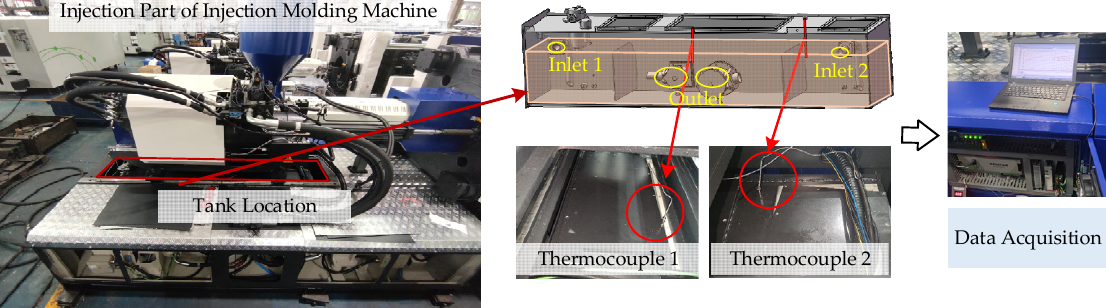
Figure 1. Heat balance experiment of injection molding machine tank. The distance between Thermocouples 1 and 2 was 0.826 m, and the test time of the tank was 4.5 h. By fitting and predicting the test curve, the temperature change curve of the inlet and outlet when the tank reaches the thermal balance state was obtained, as shown in Figure 2. The temperature of the inlet and outlet of the tank tended to stabilize after